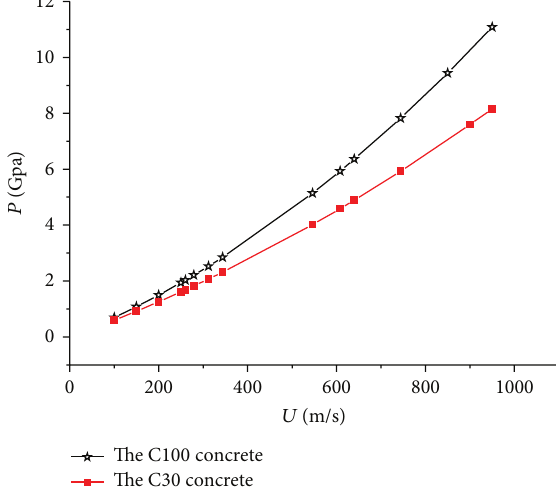
Figure 4: Stress-strain curves.